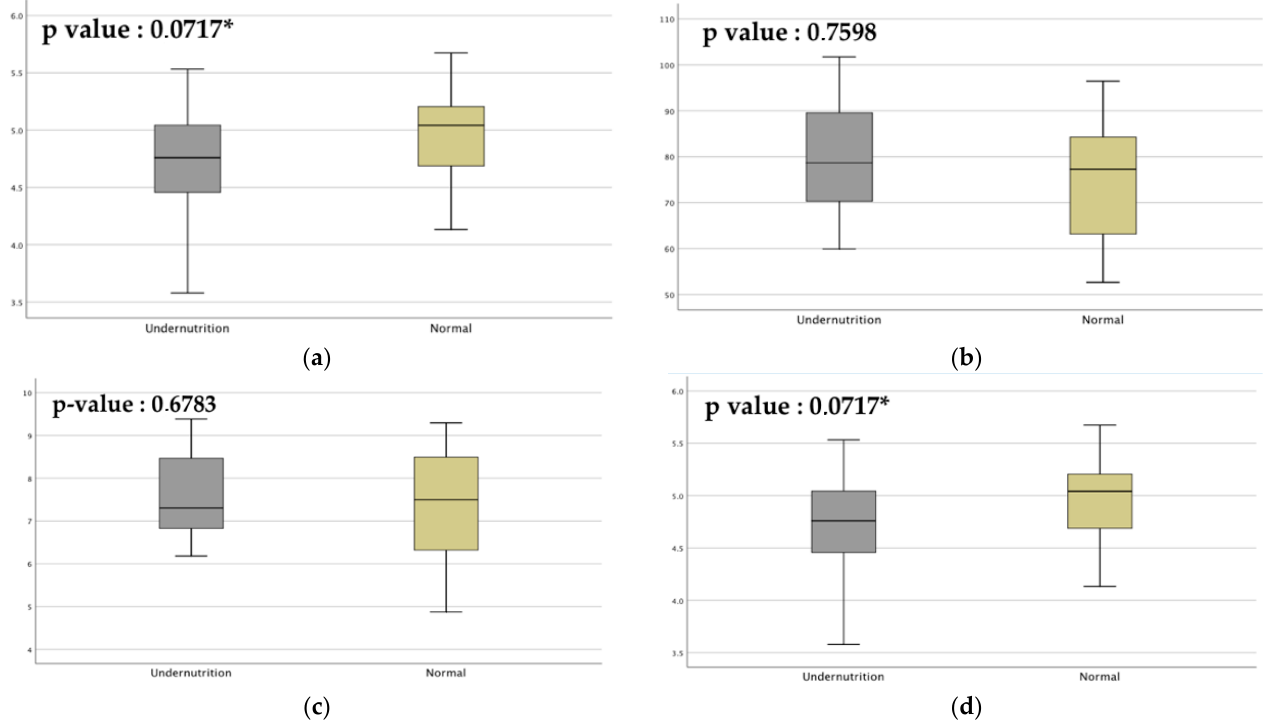
Figure 3. The significance of gut microbiota alpha diversity was calculated using an independent t -test (* p < 0.1). ( a ) Chao1, species abundance between groups; ( b ) observed OTUs, number of species or OTUs based on the community evenness; ( c ) whole-tree PD, comparison of phylogenetic diversity; ( d ) Shannon index, species diversity between